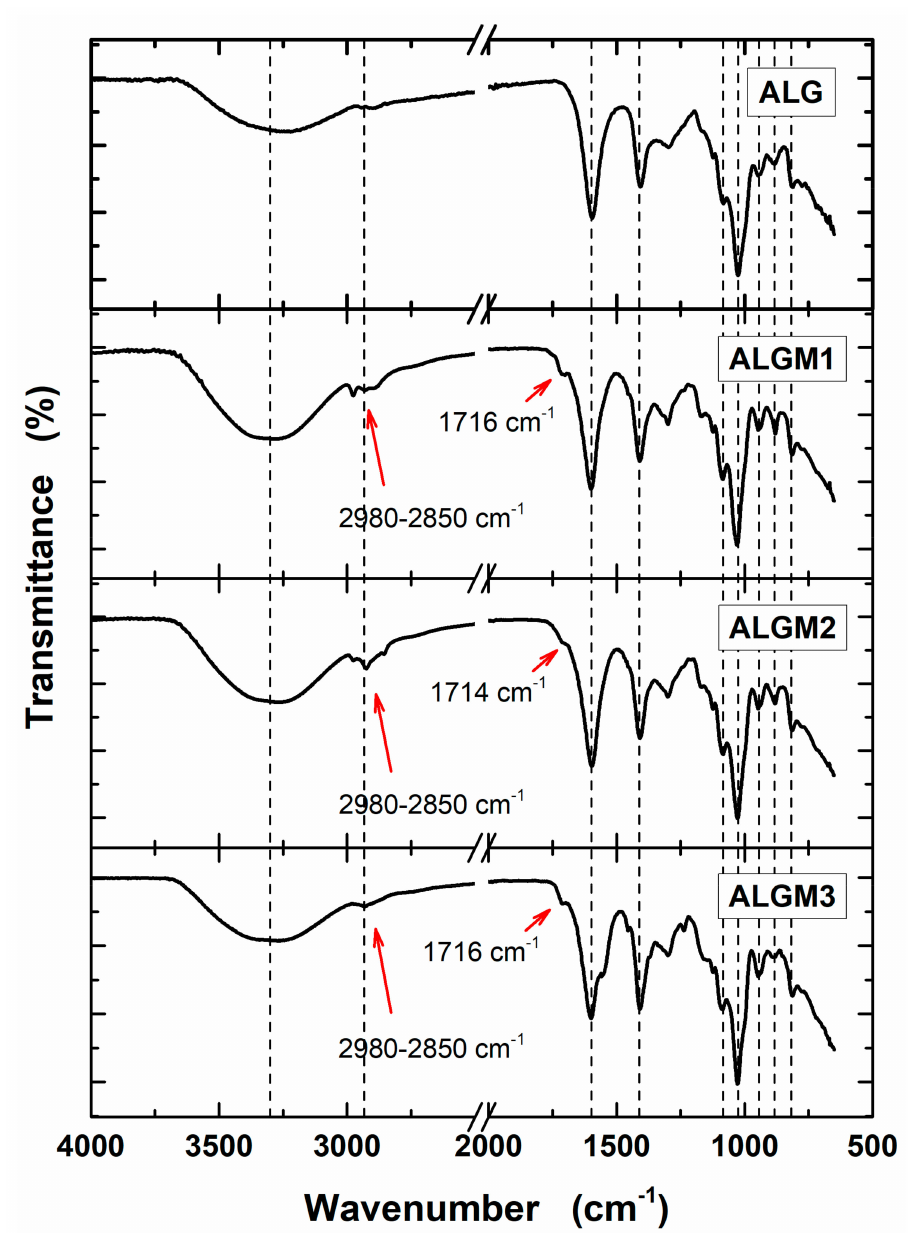
Figure 2. FTIR spectra of sodium alginate (ALG) and ALGMx macromers. The dotted lines mark bands common to all spectra. The red arrows mark the bands of the aliphatic chains (2980–2850 cm − 1 ) and carboxyl esters (ca. 1715 cm − 1 ) of the grafted Mx